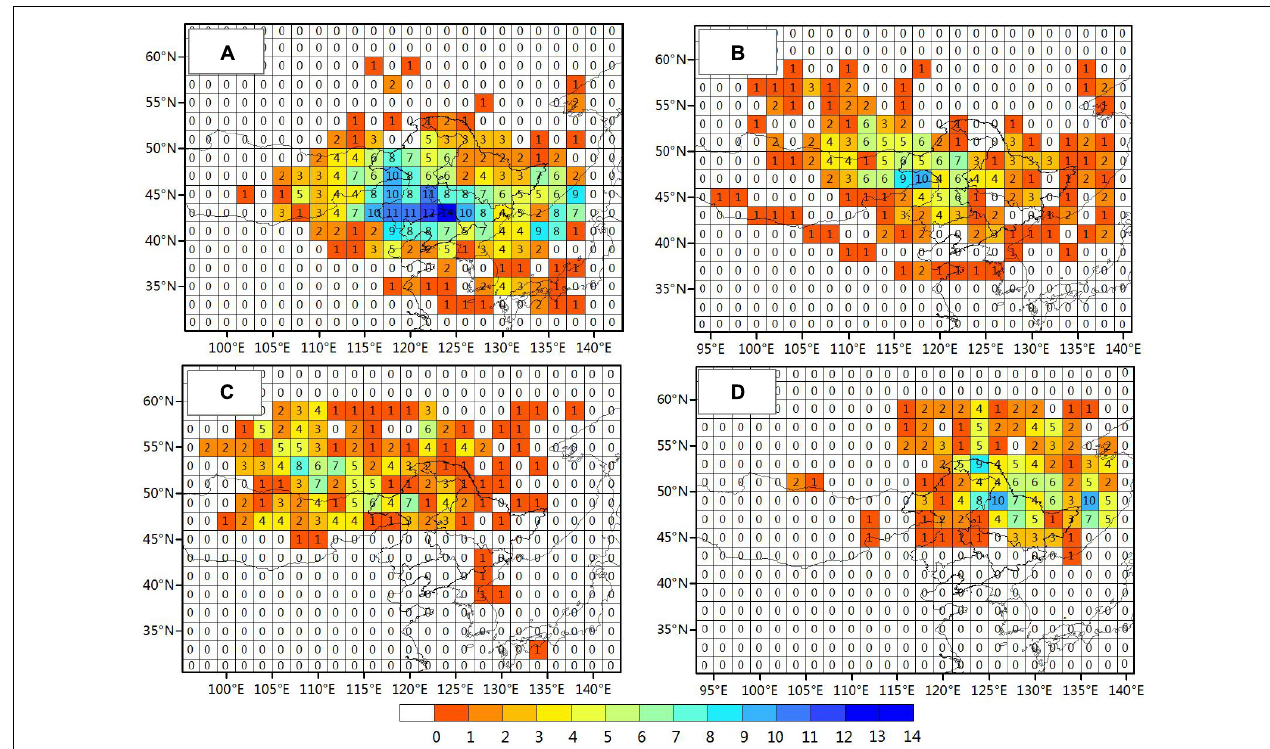
FIGURE 4 | Spatial distributions of duration days of the NCCV during 1979–2018 (unit: day): (A) EM type; (B) SLM type; (C) ESM type; (D) SSM